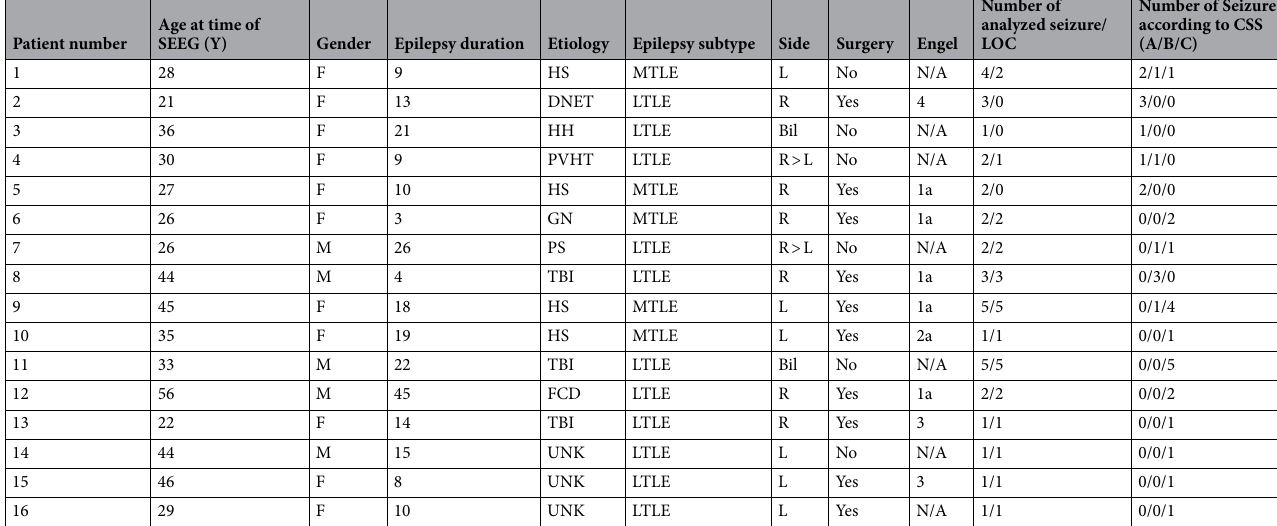
Table 1. Patients characteristics. HS: hippocampal sclerosis; DNET: dysembryoplastic neuroepithelial tumor; GN: ganglioglioma; PNH: periventricular nodular heterotopia; HH: hypothalamic hamartoma; PS: perinatal stroke; TBI: traumatic brain injury; FCD: focal cortical dysplasia; Bil: bilateral; Unk: